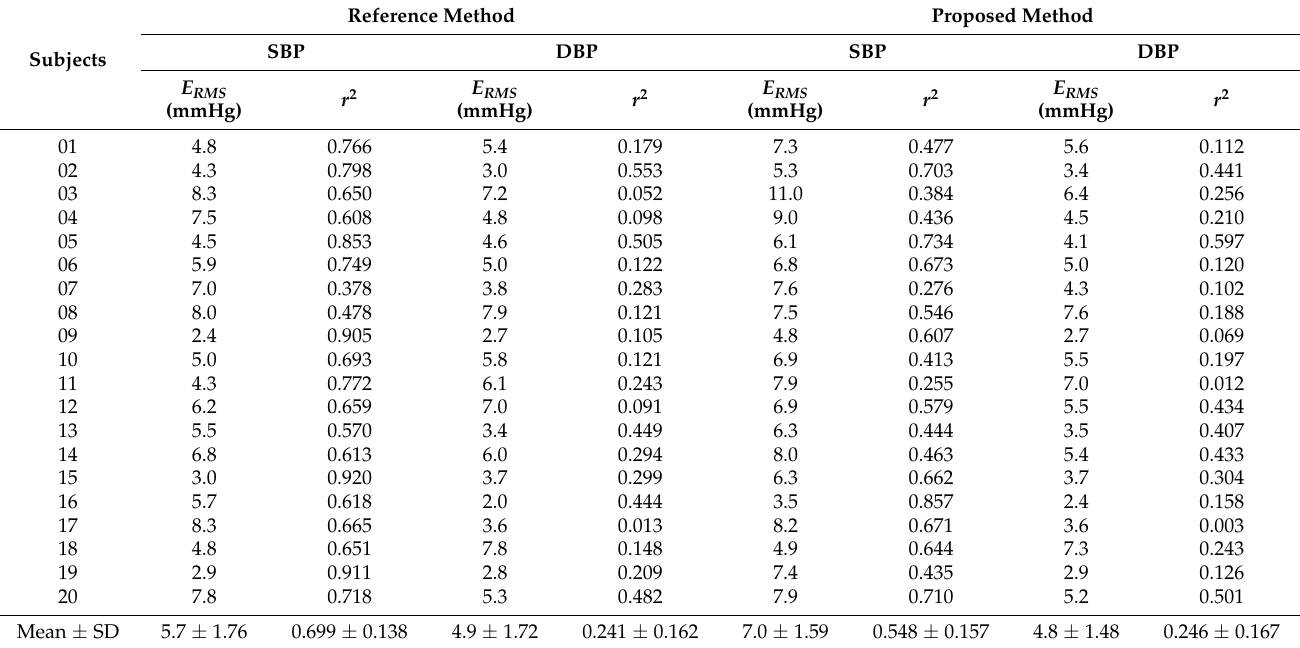
Table 4. The results of estimated systolic and diastolic blood pressures with Equation